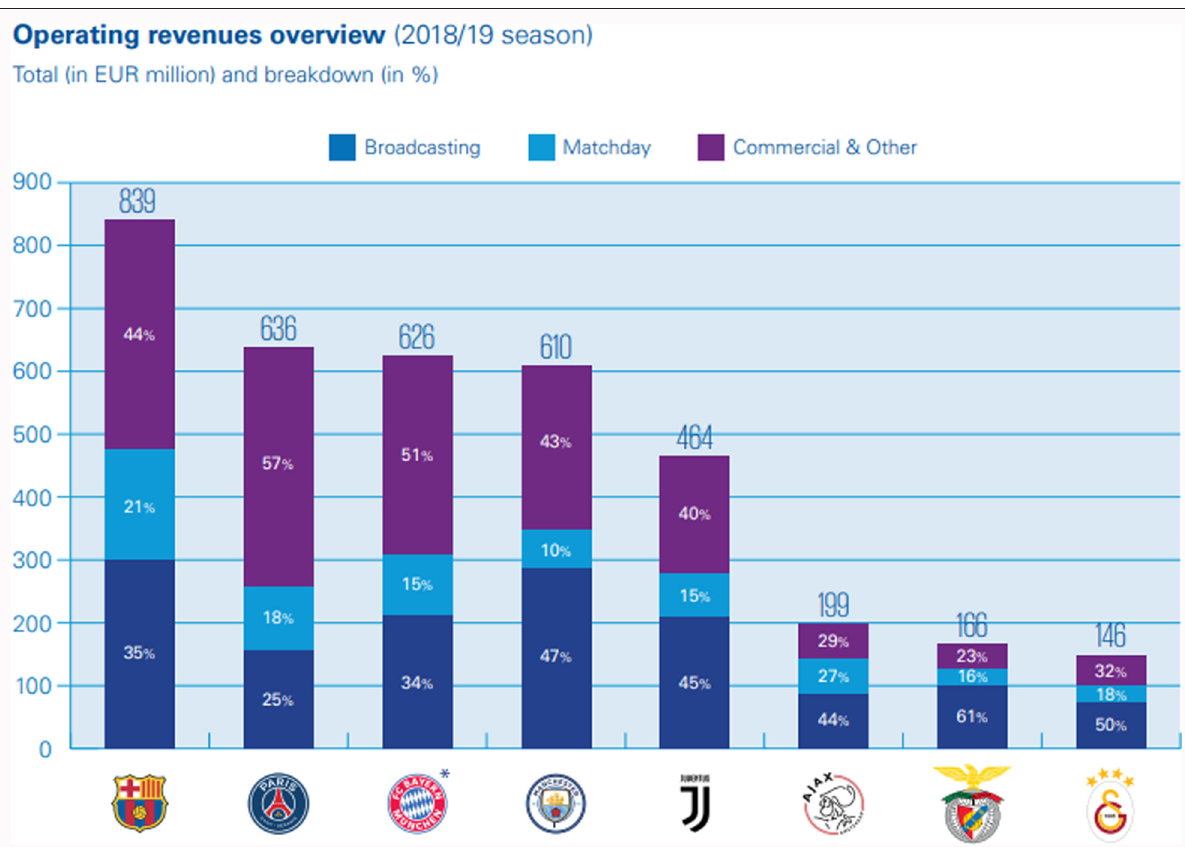
Figure 1: Operating revenues overview (2018/2019 season). Source: